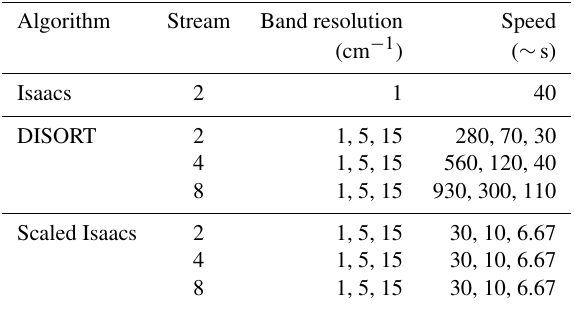
Table 5. MODTRAN simulation speed test (CPU MHz